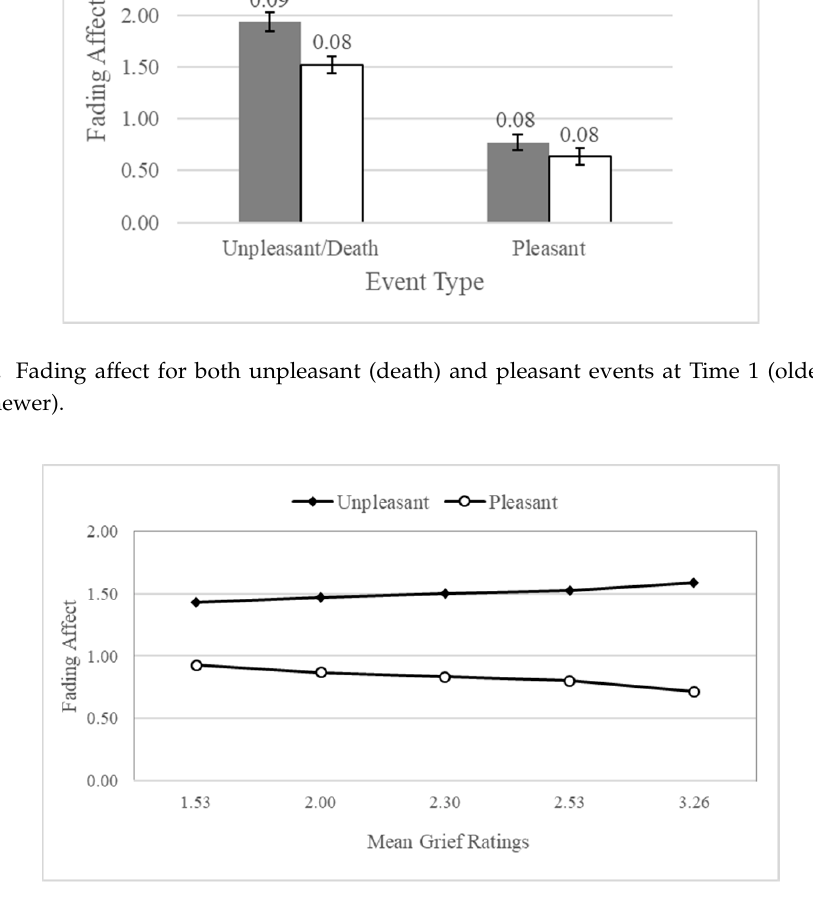
Figure 5. Fading affect for initial event affect across quintile levels (10th through 90th) of grief ratings for events. Table 2. Fading Affect Bias Regression Coefficients (SE) across Quintiles of Grief Ratings (large positive coefficients represent large FAB).